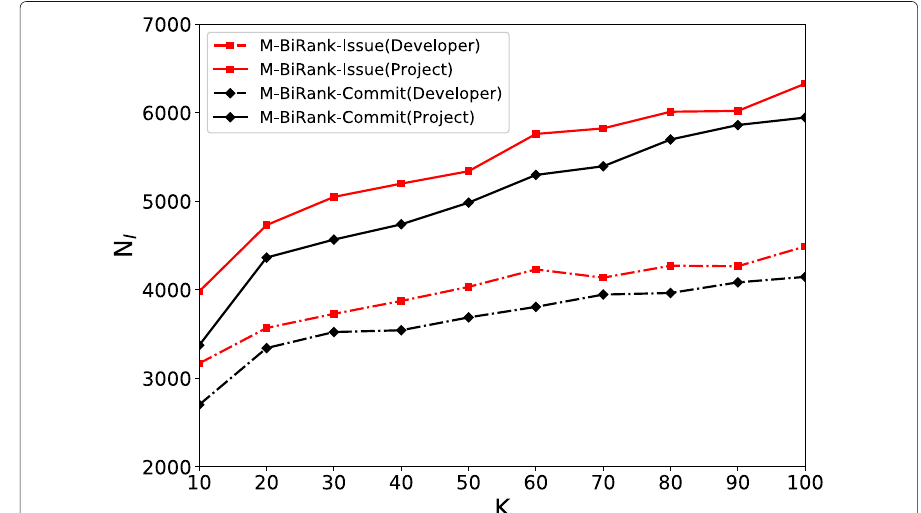
Fig. 9 Impact of the number of initial infected nodes on final infected